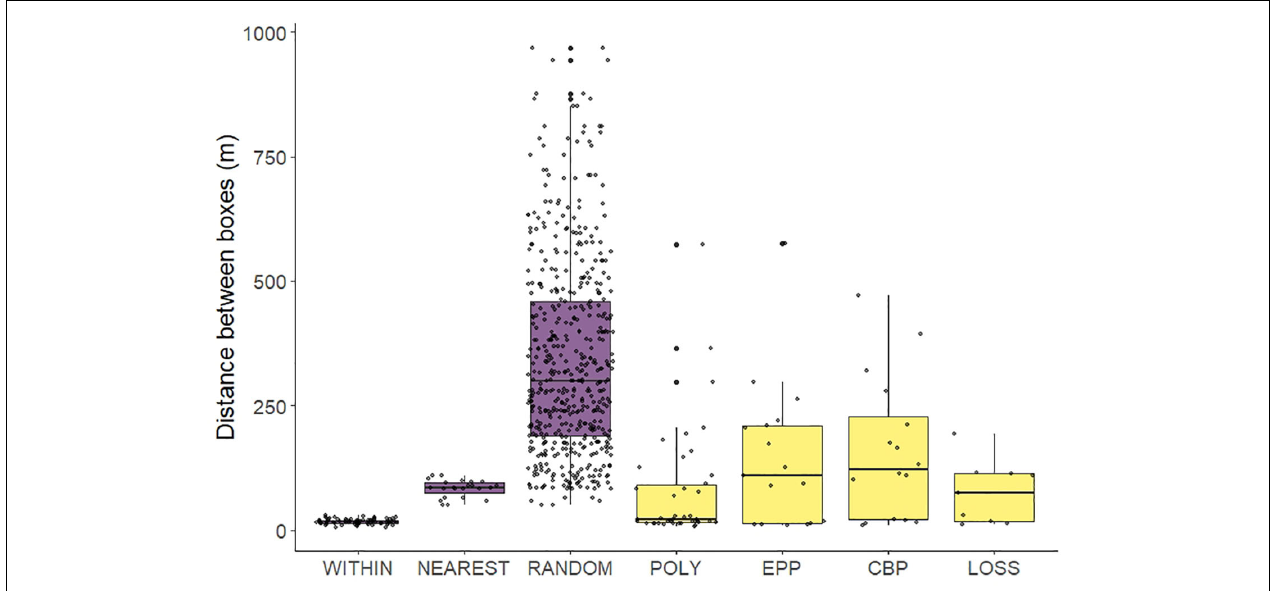
FIGURE 1 | Boxplot of distances between different nest boxes. For comparison, in mauve we represent map-derived distributions of distances within the same trio (within), between boxes at the nearest trio (nearest) and between all boxes (random). In yellow we plot distances between nests fathered by the same male: distances between the two nests of the same polygynous males (poly), between the main nest and the nest where EPY was detected (EPP), and between the main nest and the nest where CBP was identified (CBP). Finally, for females that became parasitic after losing a nest, we plot the distance between the lost nest and the nest in which the parasitic eggs were laid